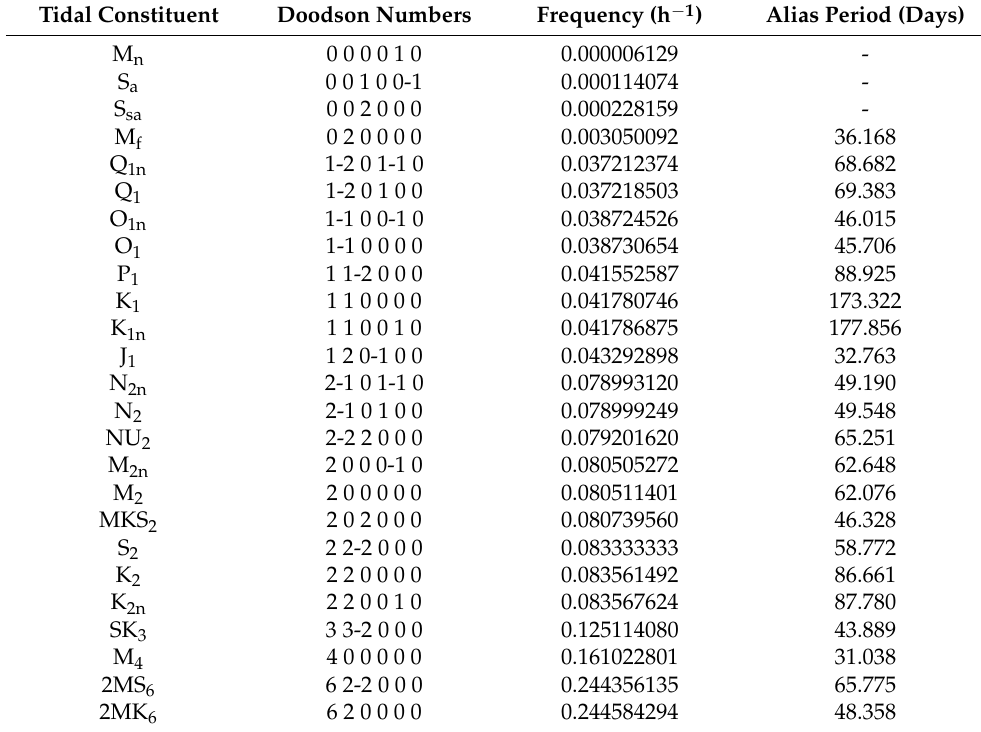
Table 2. Major tidal constituents resolved in classical harmonic analysis, showing frequency, Doodson numbers, and alias periods. The first Doodson number represents tidal species (2 means semidiurnal tide, 1 means diurnal tide, 0 means long-period